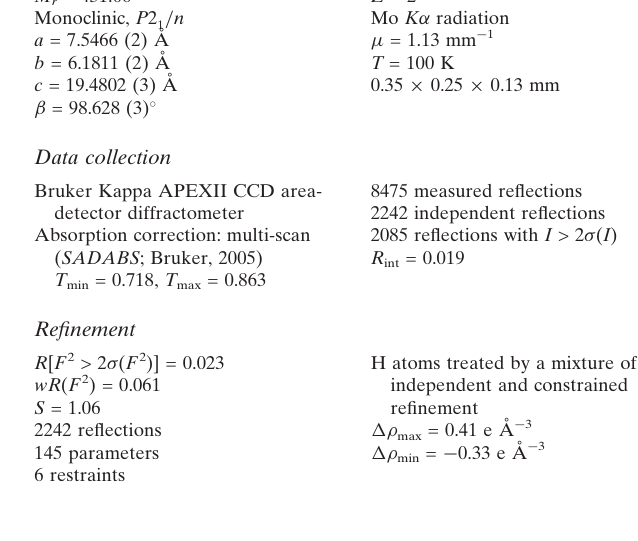
Bruker Kappa APEXII CCD area- detector diffractometer Absorption correction: multi-scan ( SADABS ; Bruker, 2005)